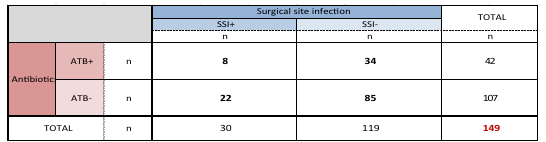
Table 1 Contingency of the 149 patients according to the occur‑ rence or not of a surgical site infection and to the presence or not of systematic post‑operative antibiotics